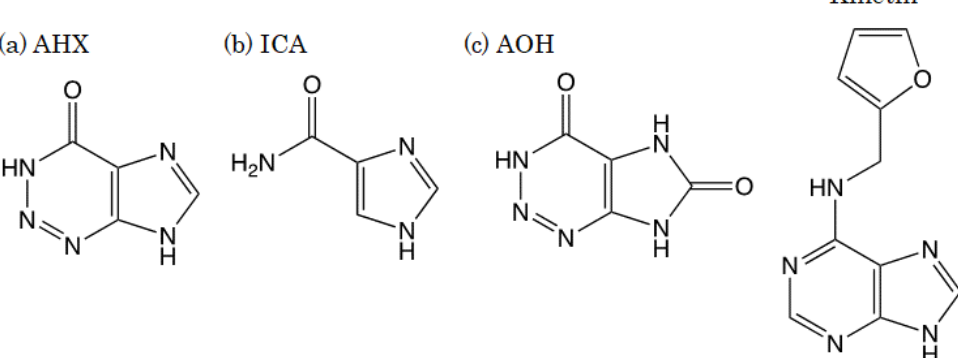
Figure 1. Structures of ( a ) 2-azahypoxanthine (AHX), ( b ) imidazole-4-carboxamide (ICA), ( c ) 2-aza-8-oxohypoxanthine (AOH), and kinetin.